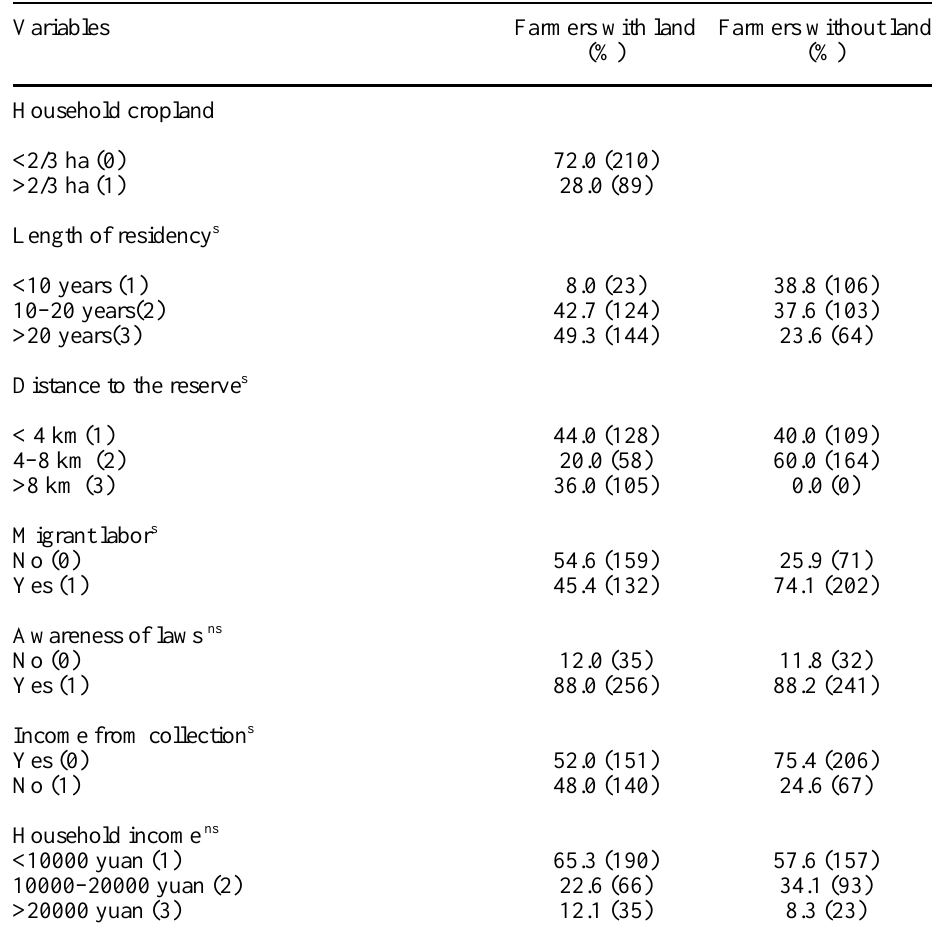
Table 2. Farmers’ household profiles and coding used in logistic regression Variables Farmers with land